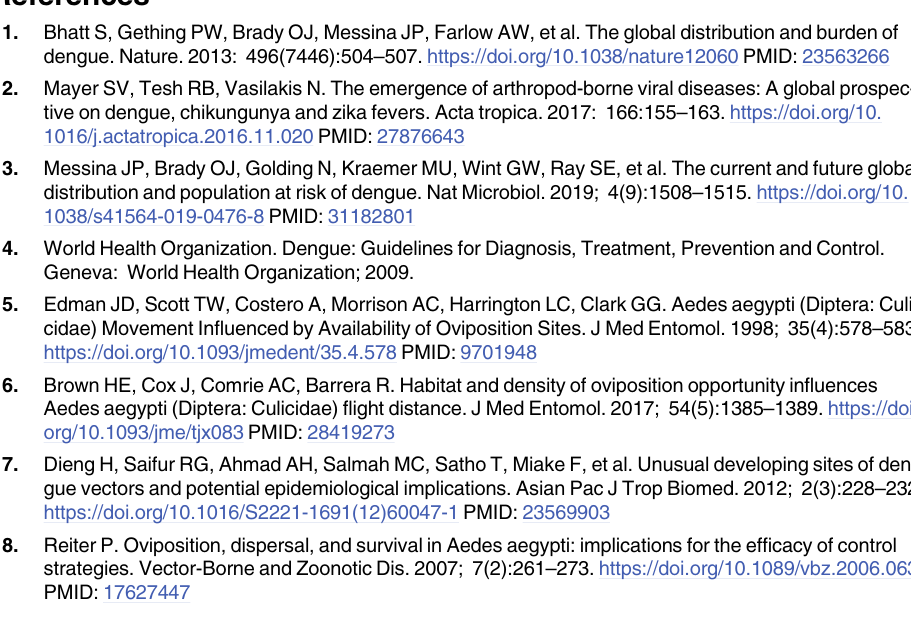
S1 Table. Summary of breeding productivity of containers with different dimensions in a simulated outdoor environment with 4, 8 or 16 breeding sites and the presence or absence of BG-Sentinel trap or Gravid Aedes